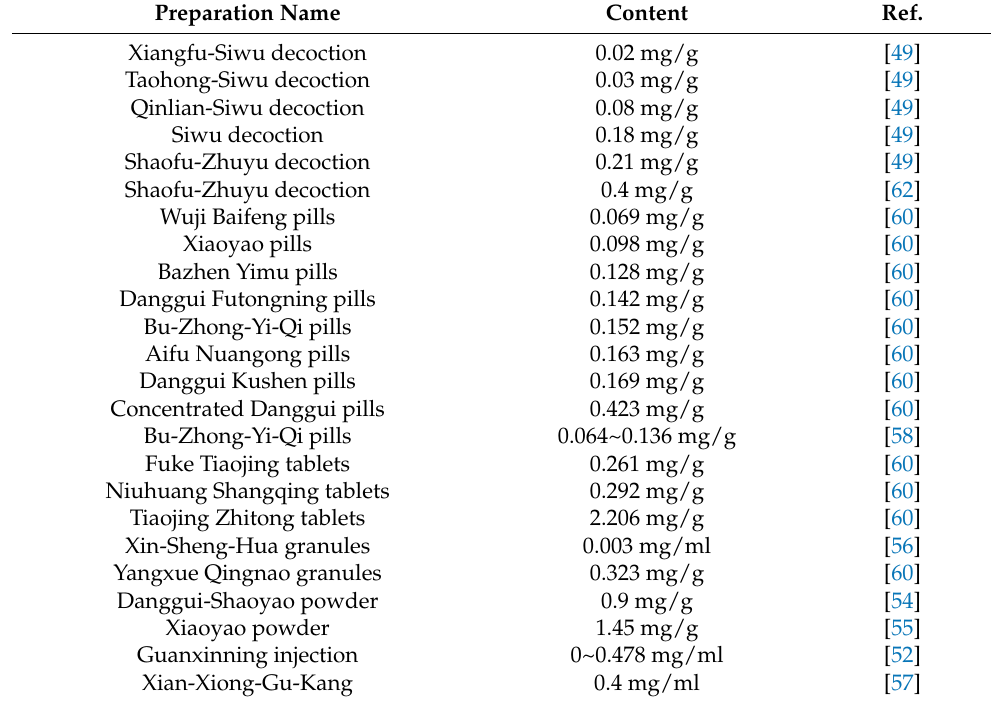
Table 3. Contents of SI in